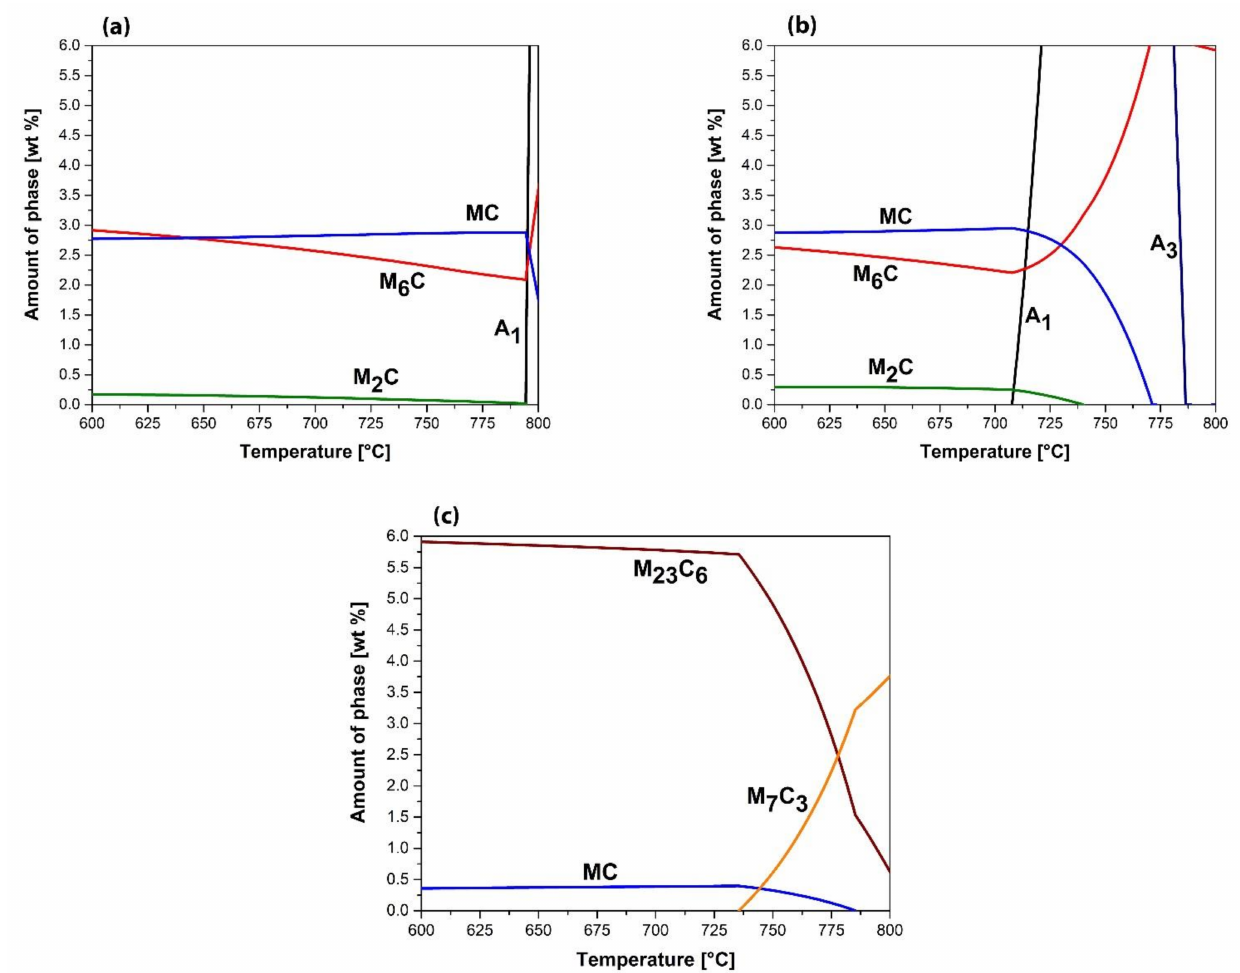
Figure 8. Thermodynamically calculated diagrams (amount of all phases vs. temperature) in the temperature range from 600 ◦ C to 800 ◦ C for HTCS-130 ( a ), W600 ( b ), and UTOPMO1 ( c ) tool